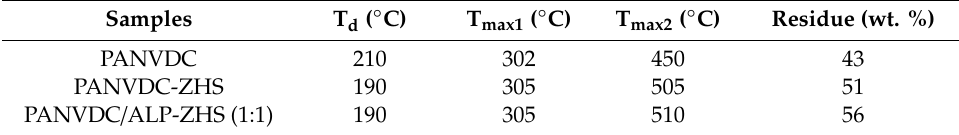
Table 3. TGA data of PANVDC, PANVDC-ZHS, and PANVDC / ALP-ZHS (1:1) films.